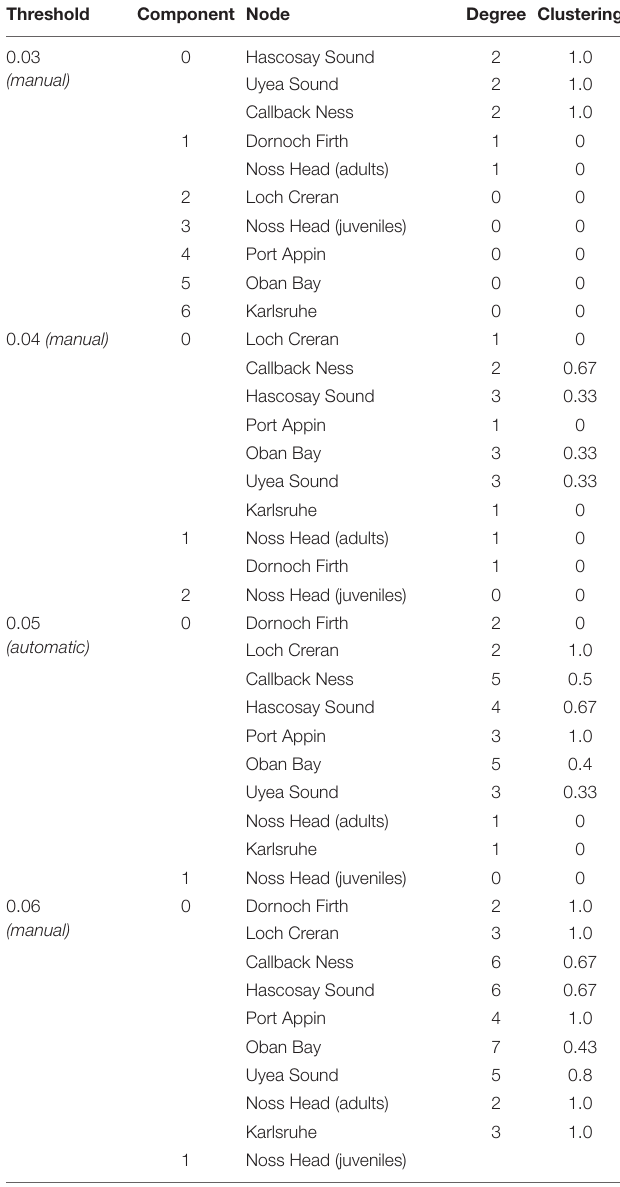
TABLE 5 | Component summary data for network visualization of Scottish M. modiolus populations at an automatic threshold value of 0.0453 (0.05) and at manual threshold values of 0.03, 0.04 and